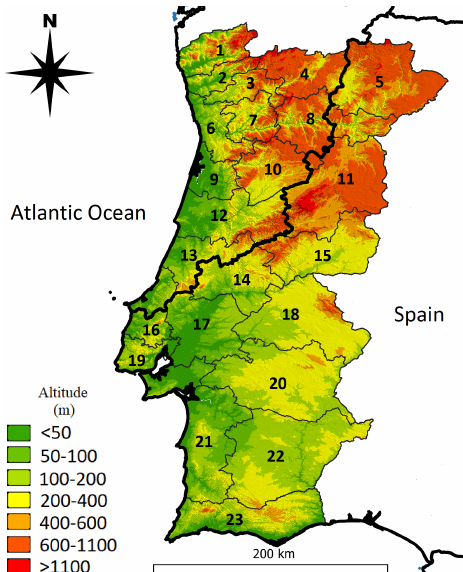
Figure 1. Mainland Portugal topography and administrative divi- sion based on NUTS 3 provinces: Alto Minho (1), Cávado (2), Ave (3), Alto Tâmega (4), Terras de Trás-os-Montes (5), Área Metropolitana do Porto (6), Tâmega e Sousa (7), Douro (8), Região de Aveiro (9), Viseu Dão-Lafões (10), Beiras e Serra da Es- trela (11), Região de Coimbra (12), Região de Leiria (13), Médio- Tejo (14), Beira Baixa (15), Oeste (16), Lezíria do Tejo (17), Alto Alentejo (18), Área Metropolitana de Lisboa (19), Alentejo Central (20), Alentejo Litoral (21), Baixo Alentejo (22) and Al- garve (23). NUTS 3 frontiers were loaded from the European En- vironment Agency (EEA, 2021) and altitude data from Direção Geral do Território (DGT, 2010). For comparison purposes, the bor- ders (thick black line) of the pyro-regions found by Calheiros et al. (2020) were also added: the NW pyro-region is located in north- western Portugal and the SW pyro-region in the southwestern and eastern parts of the